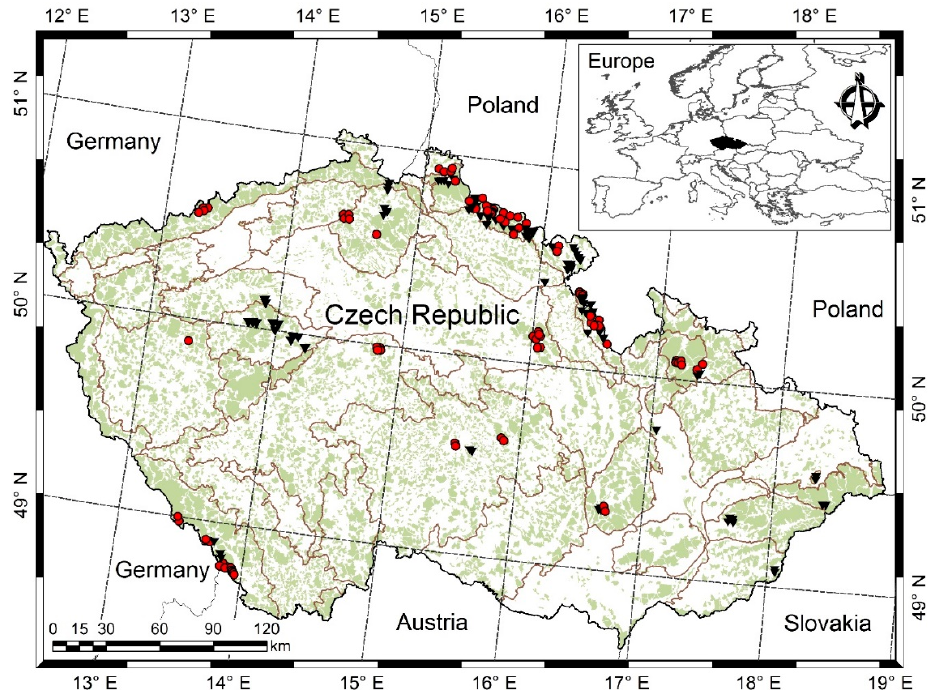
Figure 1. Sample plot locations. Monospecific Norway spruce or its abundance over other species (dark red dots), and monospecific European beech or its abundance over other species (black triangles). Light green dots show forest cover, and gray lines separate 41 Natural Forest Areas.